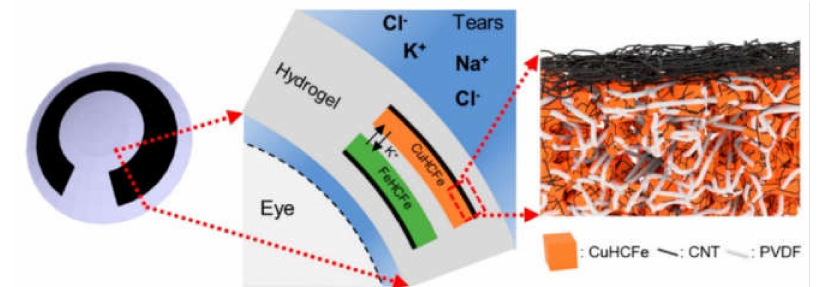
Figure 8. Aqueous battery for smart contact lenses based on polyvinylidene fluoride polymer, CNTs, and Prussian blue analogue nanoparticles CuHCFe and FeHCFe as cathode and anode, respectively. Reproduced from Yun, J. (2021) [160] © 2021 American Chemical